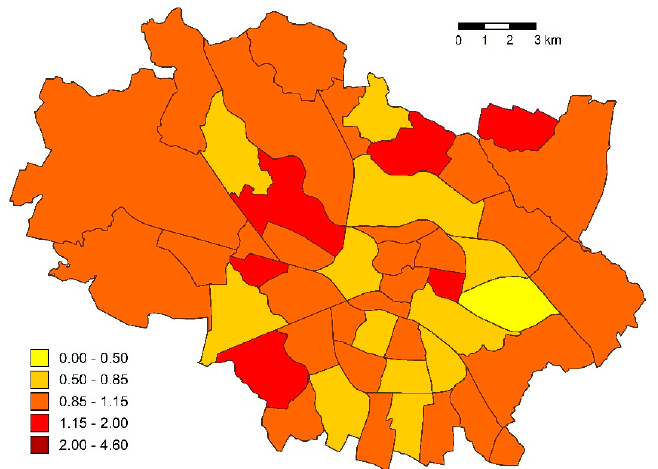
Figure 8. Concentration of medium-low-technology industrial entities in the housing estate of Wroc ł aw in 2016 (sourced by authors).